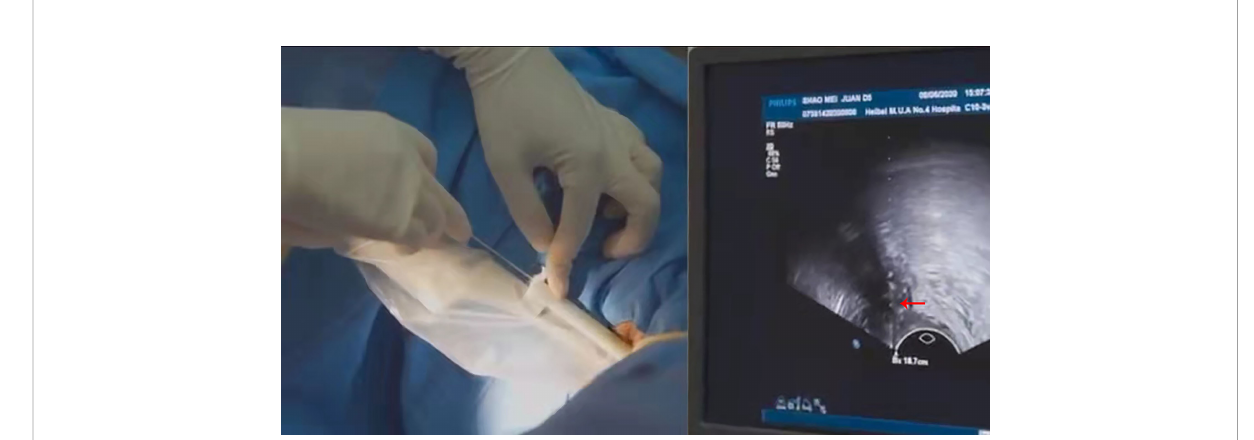
FIGURE 2 Implant therapy with the puncture bracket under transvaginal ultrasound guidance.